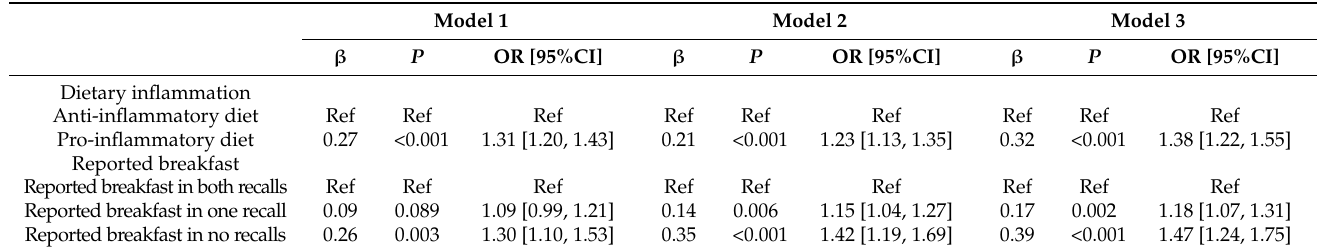
Table 2. Logistic regression model for inflammatory diet and breakfast on obesity. Model 1 Model 2 Model 3